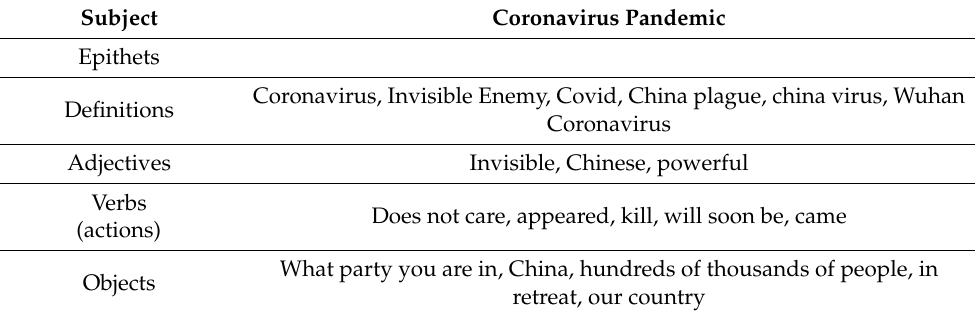
Table 6. Coronavirus pandemic.